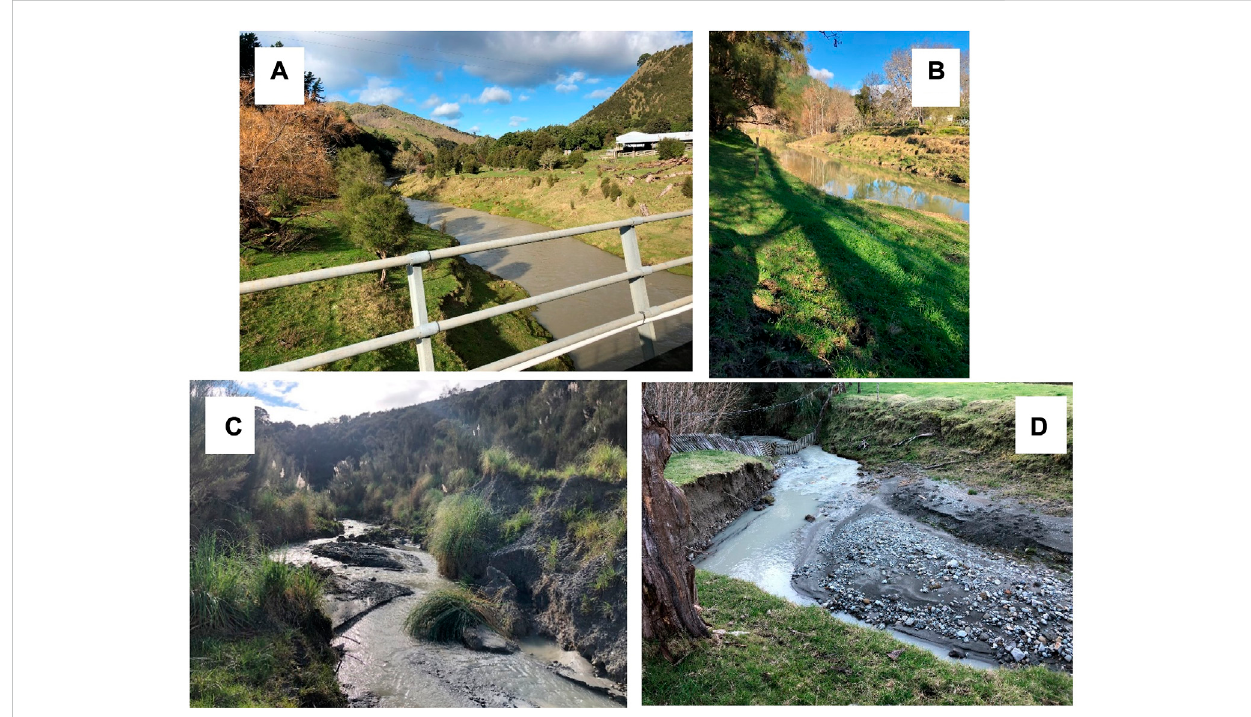
FIGURE 8 The Waimat ā River operates as a terrace-constrained fl ume-like chute that readily conveys fi ne-grained sediments (and forestry logs) from the Mountains to the Sea. Throughput reaches dominate the mid-lower course of the river, with a fl ume (slot-like) channel inset within terraces subject to recurrent reworking of the bed and banks (A, B) . Longitudinal connectivity is high, and sediment and logs are readily conveyed through the system. It is only in local transfer reaches that the channel has capacity (space) to laterally adjust (C, D)